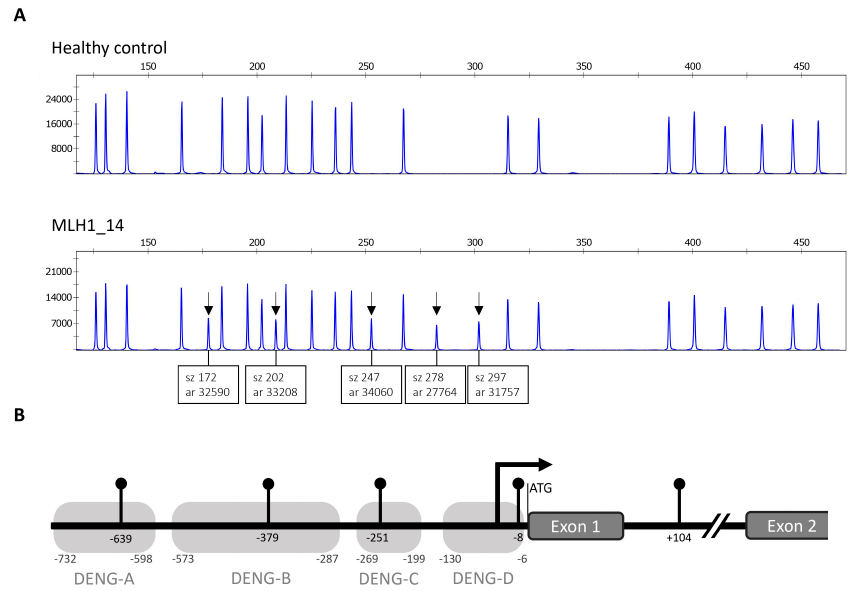
Figure 2. Details of constitutional epimutation affecting the MLH1 promoter in case MLH1_14. ( A ) MS-MLPA tracing of the MLH1 promoter region including five methylation-sensitive sites monitored in the assay. The presence of a peak at a methylation-sensitive site indicates methylation, the degree of which D m , the methylation dosage ratio, can be calculated from the peak areas, whereas the absence of a peak indicates no methylation (the remaining peaks shown in the figure represent reference genomic areas lacking HhaI sites). All five methylation-sensitive sites (arrows) are methylated in leukocyte-derived DNA from MLH1_14 and unmethylated in a healthy control. Normalized D m values around 0.5 suggest that one allele is likely to be fully methylated and the other allele unmethylated in MLH1_14. ( B ) Diagram of the MLH1 promoter region showing the positions of the methylation-sensitive sites (lollipops) relative to the translation start codon ATG (for initiating methionine). From Deng et al. [15], areas A–D are depicted, and area C closely correlates with expressional silencing. Bent arrow indicates transcription start according to Deng et al. [15].